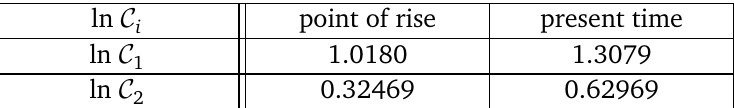
and is a = 0.245 and scale C 1 C 2